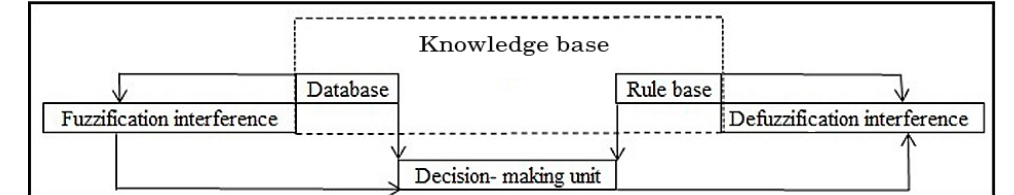
fig. 1. flow diagram of fuzzy inference